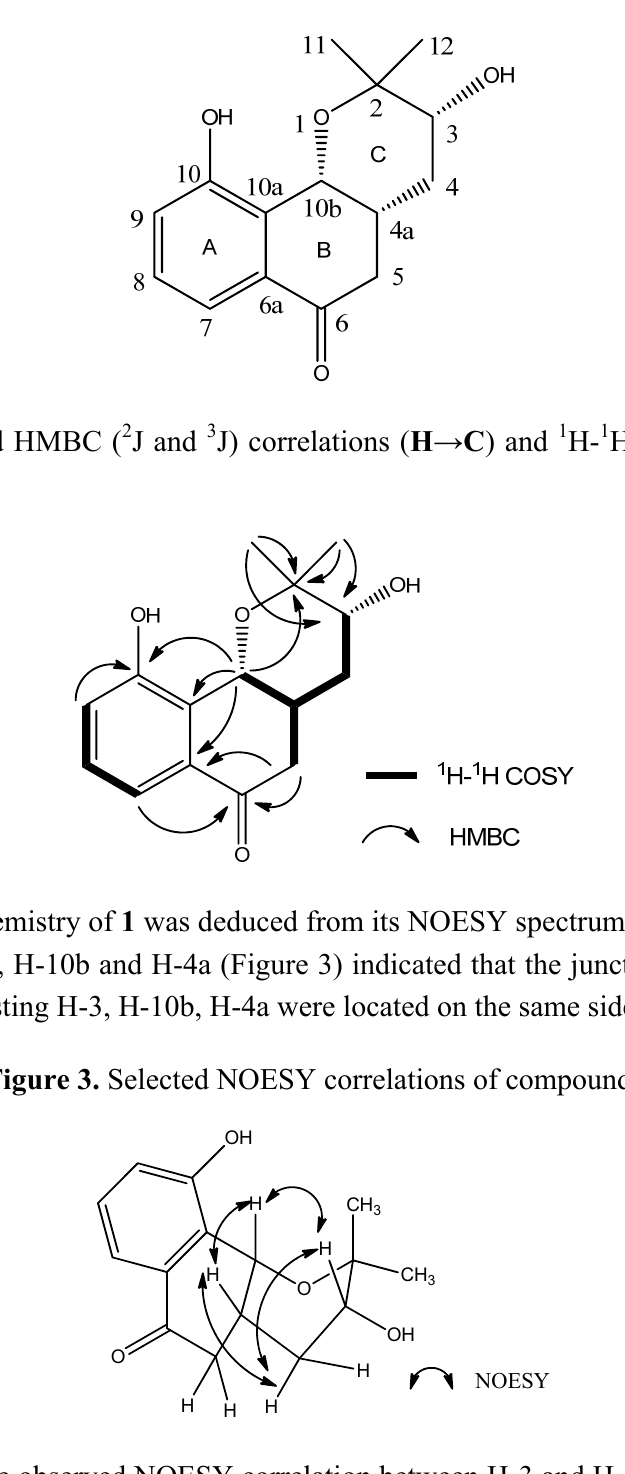
Figure 1. Structure of compound 1 .